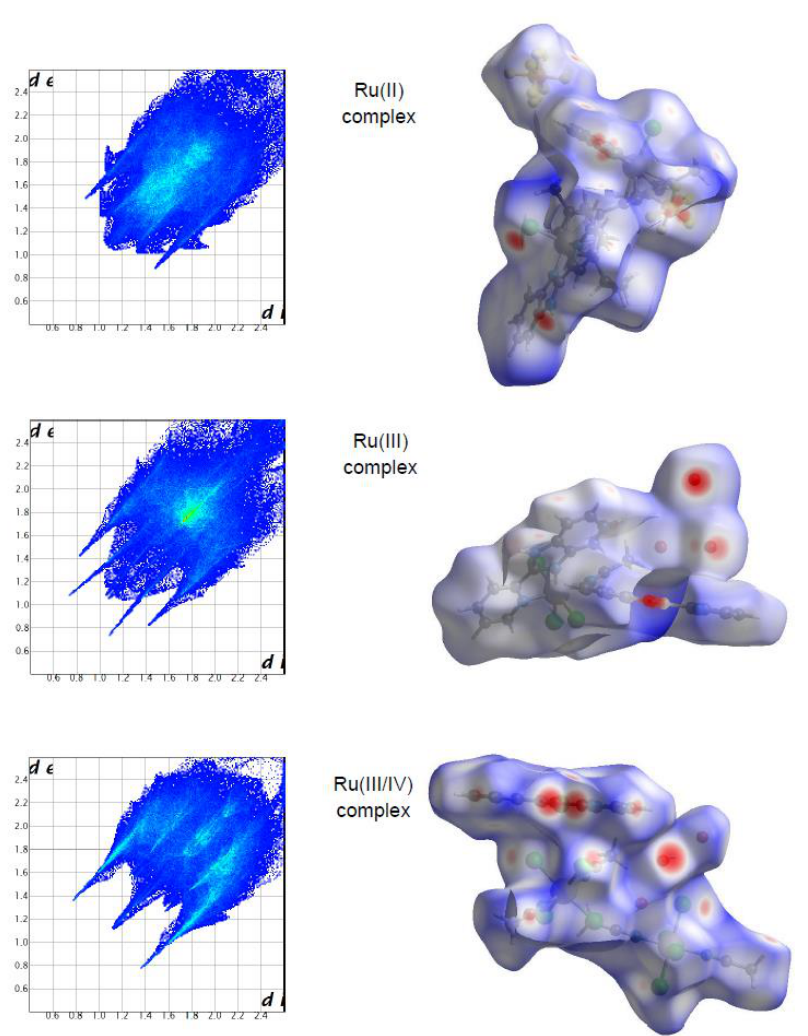
Figure 2. Two-dimensional fingerprint plots for all intermolecular contacts in the Ru complexes. Surfaces to the right highlight the relevant d norm surface patches associated with the specific con- tacts.